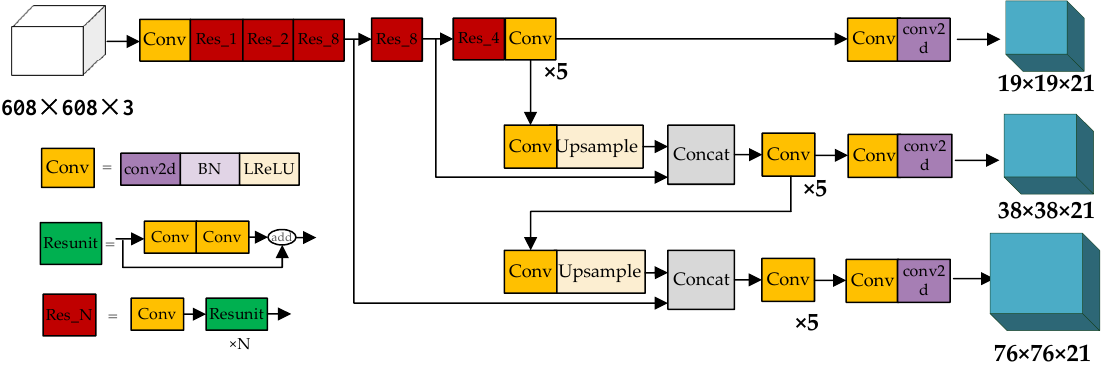
Figure 4. YOLOv3 structure.